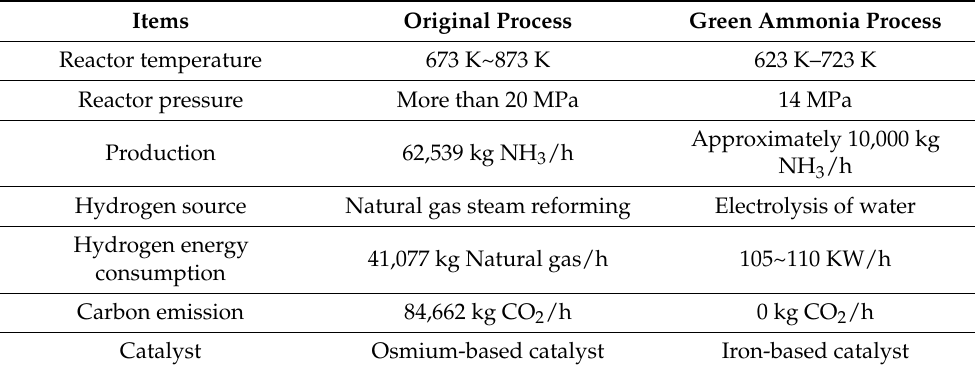
Table 1. Technological comparison of the green ammonia process and the original